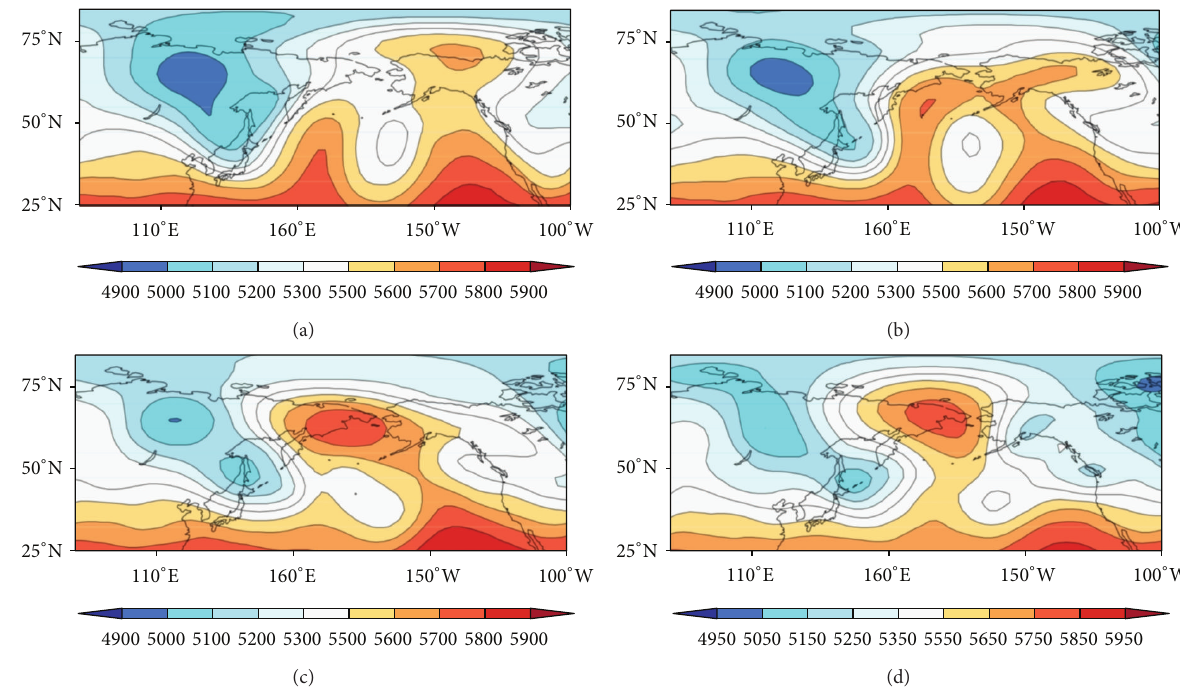
Figure 5: Upstream 500 hPa ridge in (m) merging with the block: (a) Feb. 4th, (b) Feb. 5th, (c) Feb. 6th, and (d) Feb. 7th.